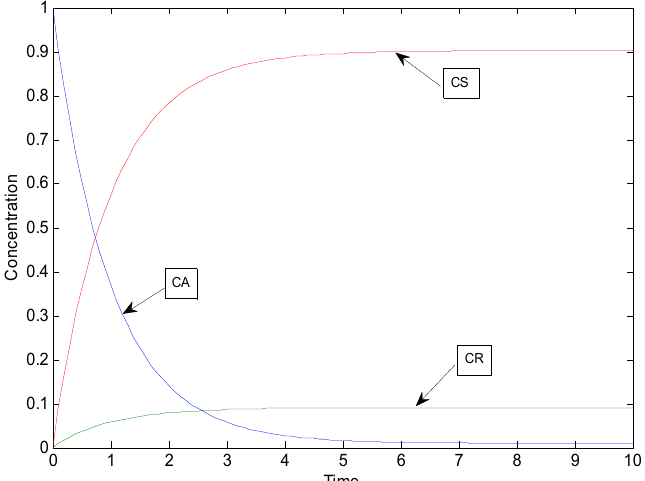
Figure 2. Concentration profiles of the special case of consecutive reactions with parameters: k 1 = 1, K 1 = 10 and K 2 = 10.